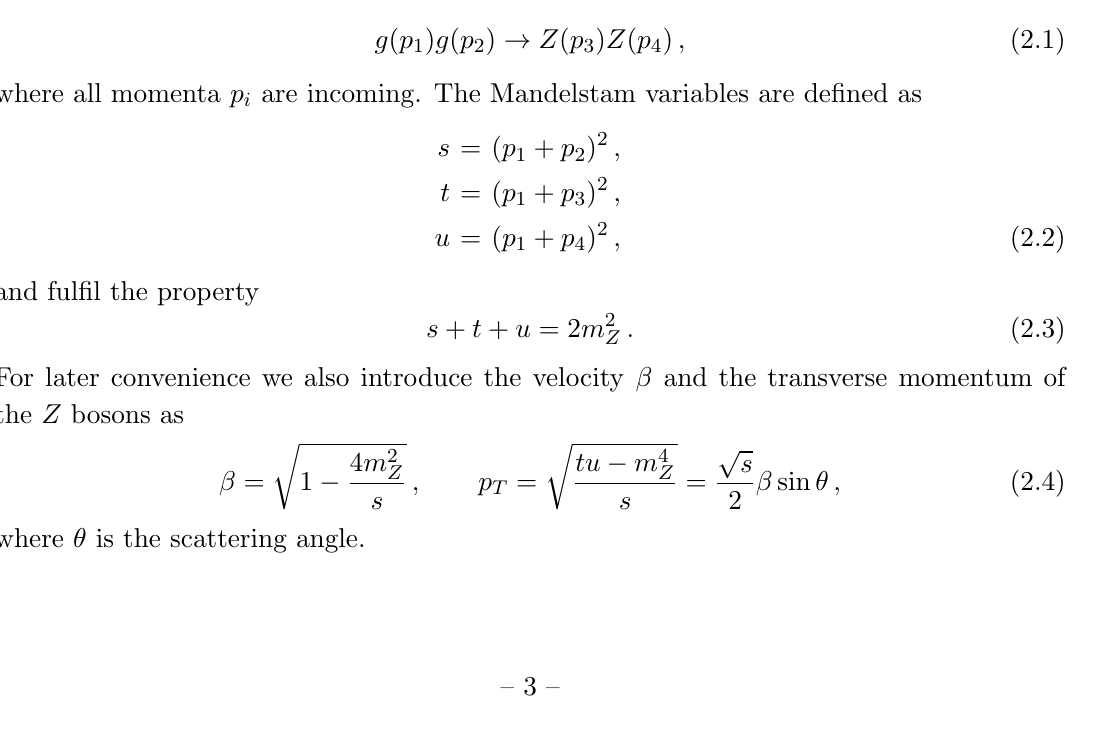
Figure 1 . Sample LO and NLO Feynman diagrams for gg (such as the third diagram) are known, and not considered